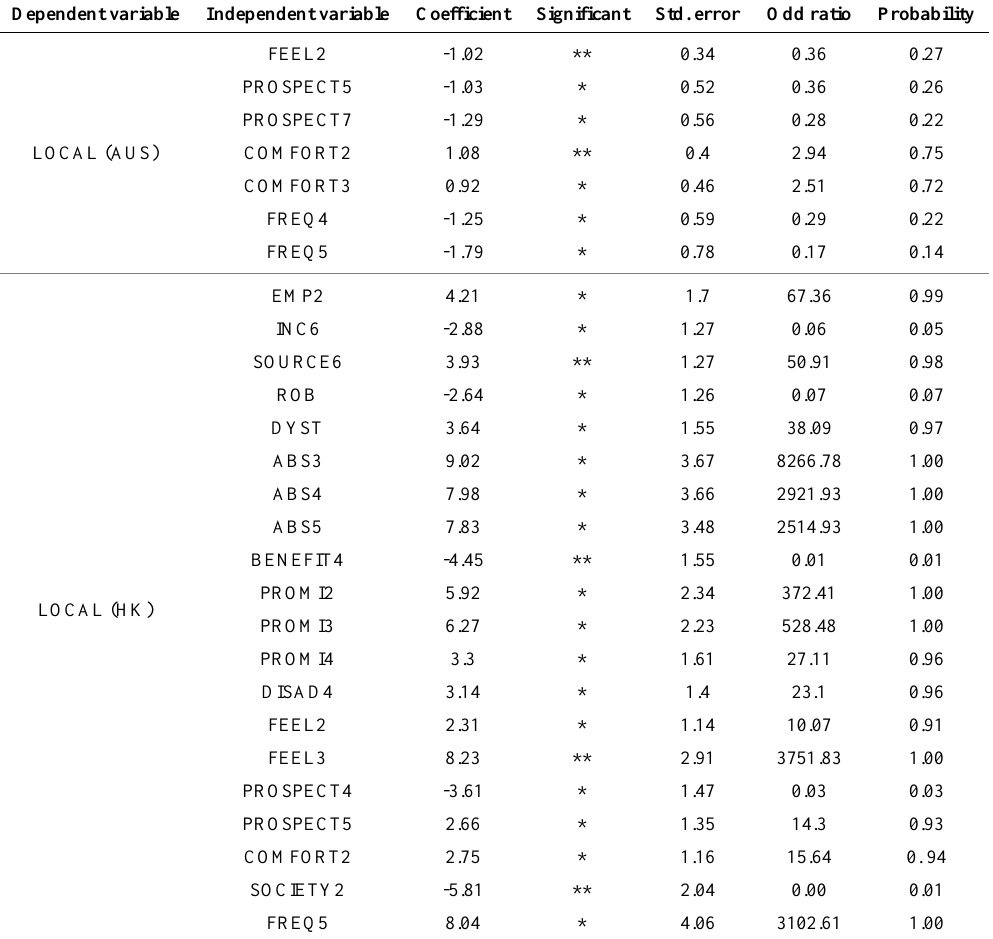
Table 5. Regression model for the estimation of “limited local government financial resources and investment capabilities for AI projects” as a key challenge for local governments from Australia and Hong Kong Dependent variable Independent variable Coefficient